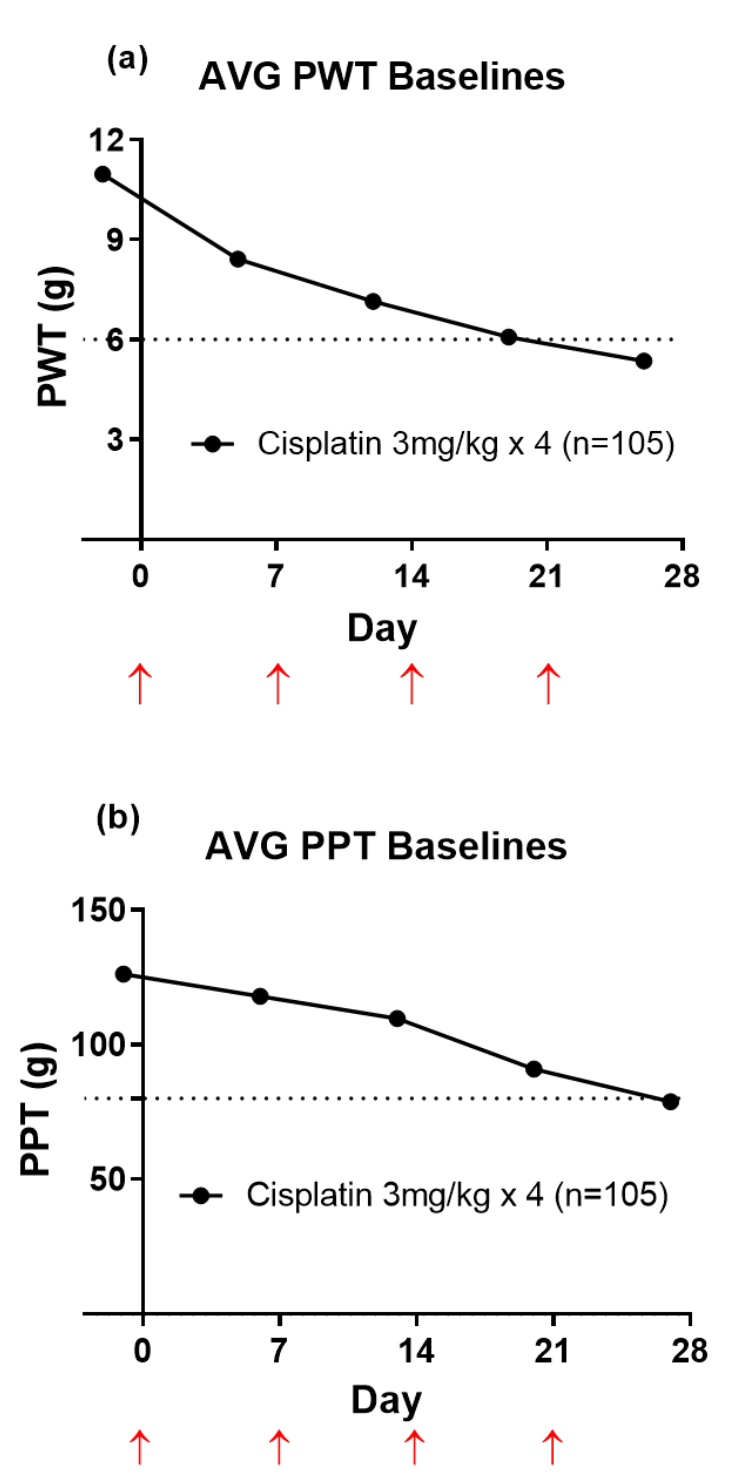
Figure 1. ( a ) Mean ( ± SEM) baseline paw withdrawal threshold (PWT) versus time curves. The horizontal dotted line in Panel ( a ) indicates fully developed mechanical allodynia in the bilateral hindpaws (PWT ≤ 6 g). ( b ) Mean ( ± SEM) baseline paw pressure threshold (PPT) versus time curves. The horizontal dotted line in Panel ( b ) indicates fully developed mechanical hyperalgesia in the bilateral hindpaws (PPT ≤ 80 g). Red upward pointing arrows indicate the days of each cisplatin (3 mg/kg; IP) injection. Please note that the error bars have been added, but they cannot be seen as the data is very tight (n = 105).